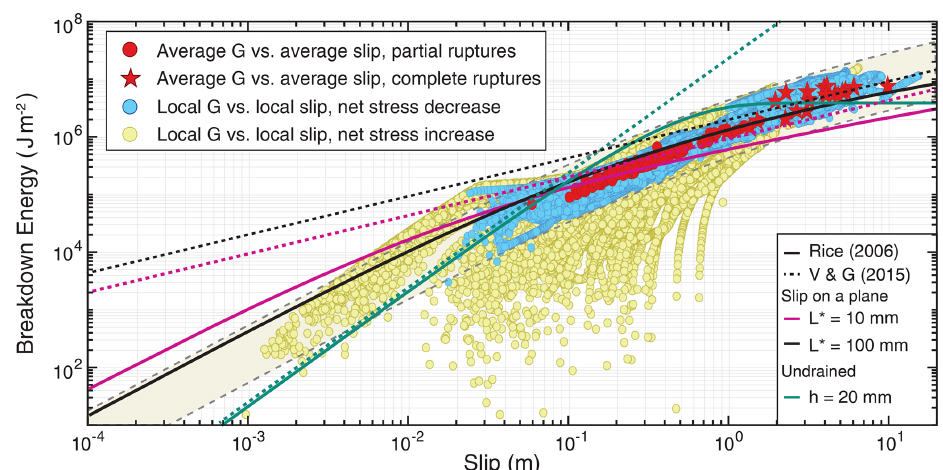
Figure 11. The average and local breakdown energy values for the simulated ruptures show an increasing trend with average and local slip, consistent with inferences from natural earthquakes (Fig. 4). The general trend of increasing breakdown energy with slip qualitatively holds for local points within our simulated ruptures; however, there is considerable variability for individual values of G at a given slip. For points that exhibit net weakening behavior in our simulated ruptures (blue circles), local values of G tend to vary within a factor of 3 from the scaling relationship between average G and average slip. The shaded band bordered by gray dashed lines illustrates the variation in G at a given value of slip. Local values of G are more variable for regions that experience a net increase in stress during the rupture process (yellow circles), e.g., regions close to rupture arrest. Theoretical curves for G vs. slip are indicated by solid lines for Eqs. (17) and (21) based on Rice (2006) and dashed lines for Eqs. (22)–(23) based on Viesca and Garagash (2015), with the coefficient of friction of f = 0 . 53 and the values otherwise indicated in Table 1. In both cases, the magenta and black lines correspond to the solutions for slip on a plane with two different values of L ∗ , and the green line corresponds to the solution for an adiabatic and undrained shear band of 20mm